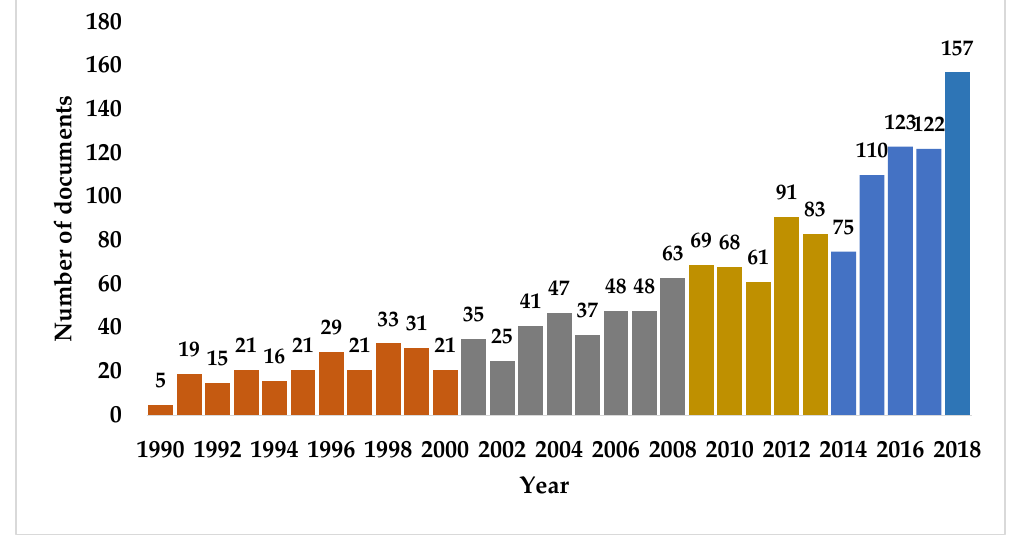
Figure 2. Land degradation research documents published from 1990 to 2018.